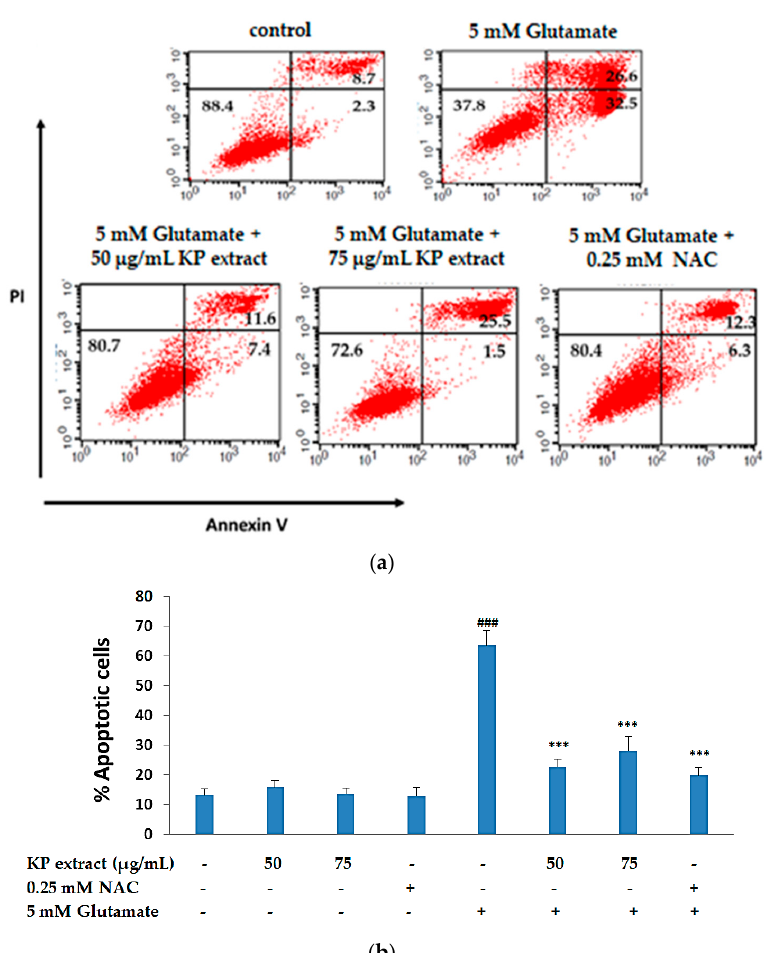
Figure 3. The anti-apoptotic activity of KP extract on HT-22 cells. ( a ) Representative flow cytometry plots using Annexin V-FITC/PI staining in each group including an untreated group (control), 50 and 75 μ g/mL of KP extract treatment in the presence or absence of 5 mM of glutamate for 14 h. NAC (0.25 mM) was used as positive control; ( b ) bar graph indicates the percentage of apoptotic cells (PI-/annexin V + stained cell population). Data are presented as the mean ± SEM (n = 3). ### p < 0.001 vs. control and *** p < 0.001 vs. 5 mM of glutamate . The symbol "-" and "+" are defined as absent and present, respectively.